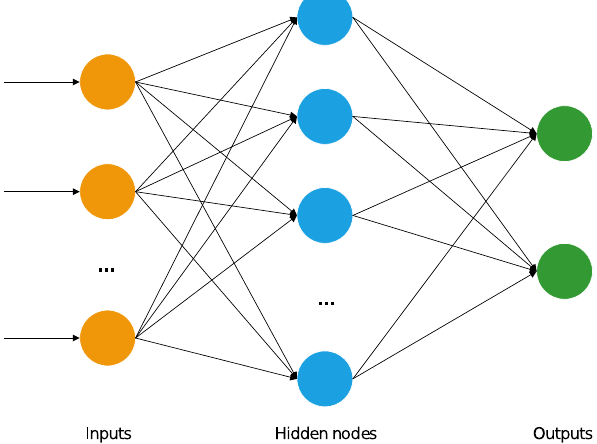
Figure 1. Schematic of neural network